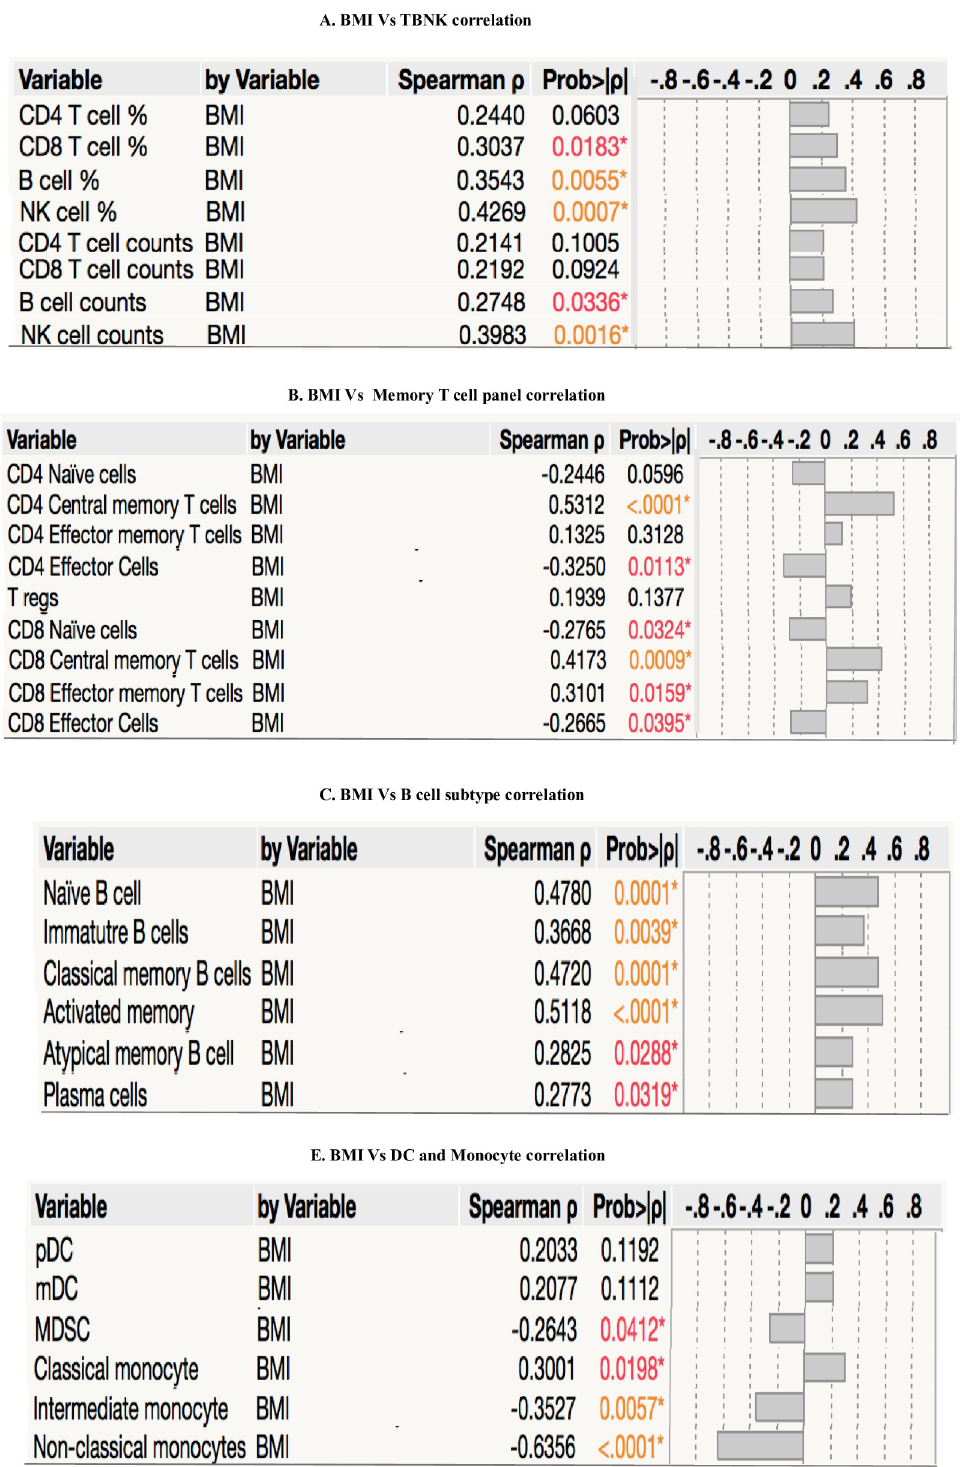
Fig 5. Relationship between immune cells and BMI. Relationship between immune cell frequencies and BMI in LTBI individuals. The relationship between the (A) Frequencies and cell counts of CD4 + T cells, CD8 + T cells, B cells and NK cells and BMI were examined in all individuals with LTBI (n = 60). (B) Frequencies of CD4 + T cells, CD8 + memory T cells and BMI were assessed in LTBI (n = 60) (C) Frequencies of B cell subsets and BMI were assessed in LTBI (n = 60) (D) Frequencies of monocyte and DC subsets and BMI were assessed in LTBI (n = 60). The data are depicted as